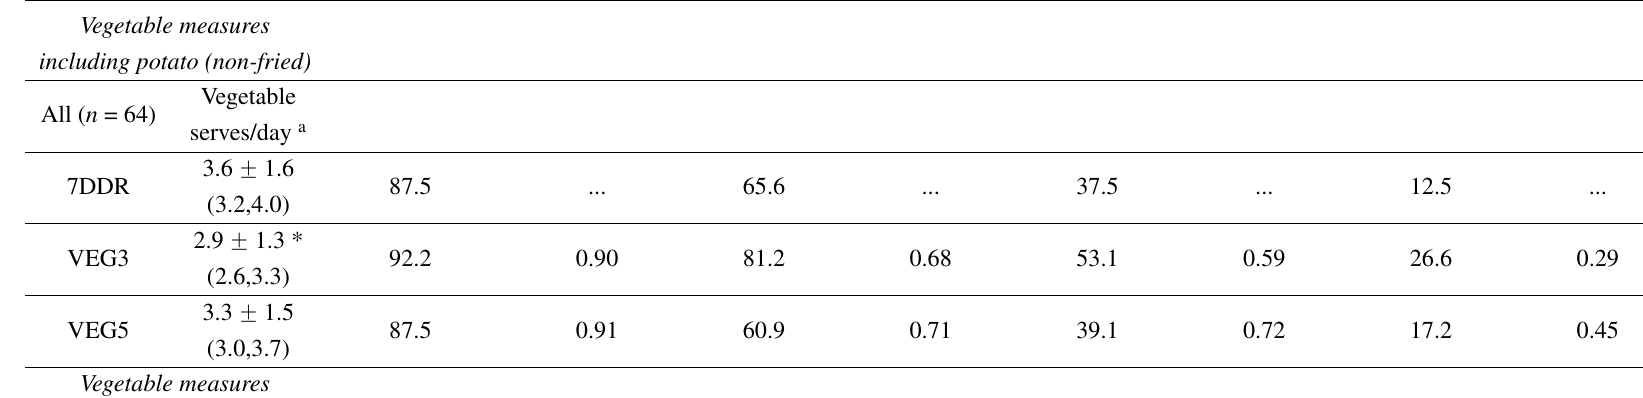
Table 1. Estimation of usual total vegetable intake by VEG3 and VEG5 in comparison to 7-day estimated dietary records (7DDR) measures of mean vegetable intake, and predictive value of VEG3 and VEG5 for different vegetable intake levels. <5 serves/day <4 serves/day <3 serves/day <2 serves/day Prevalence b , Positive Prevalence, Positive Prevalence, Positive Prevalence, Positive % Predictive Value % Predictive Value % Predictive Value % Predictive